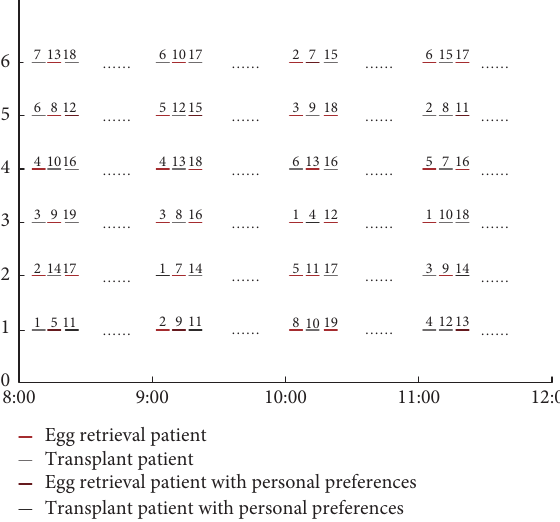
Figure 6: Scheduling Gantt diagram based on sequence rules.